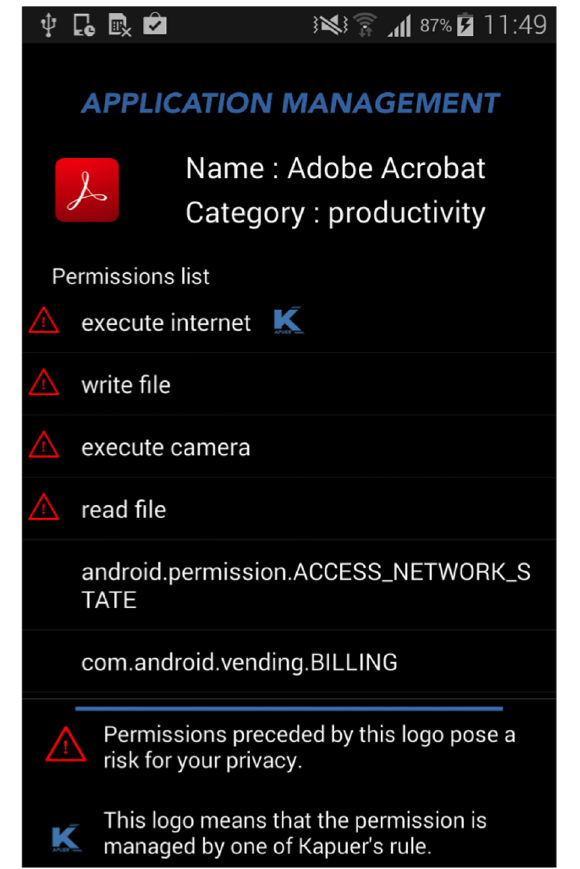
Fig. 10 Application information